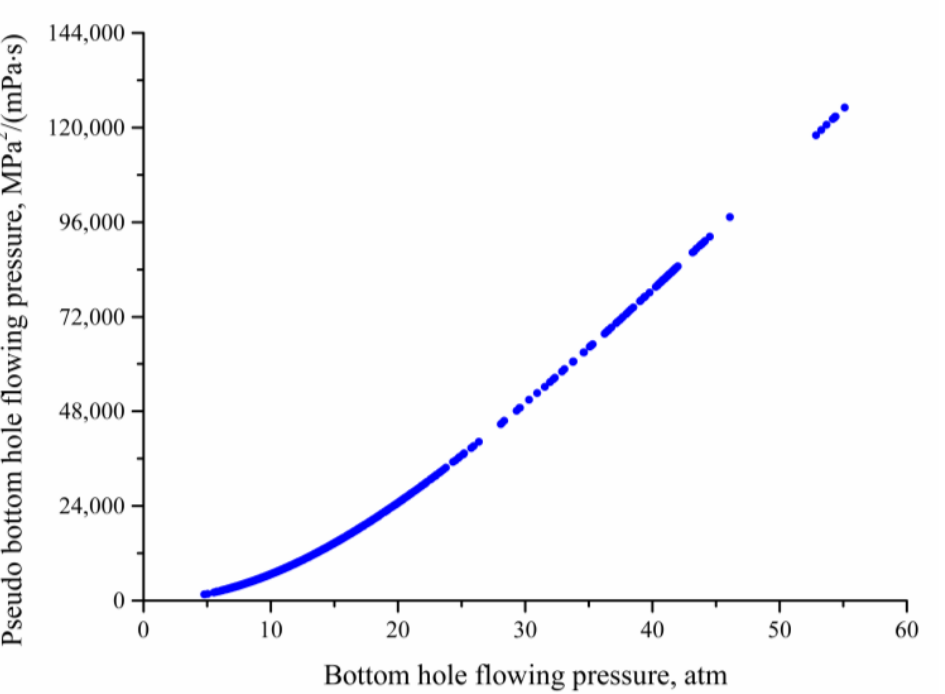
Figure 5. Pseudo bottom hole flowing pressure vs. bottom hole flowing pressure curve.